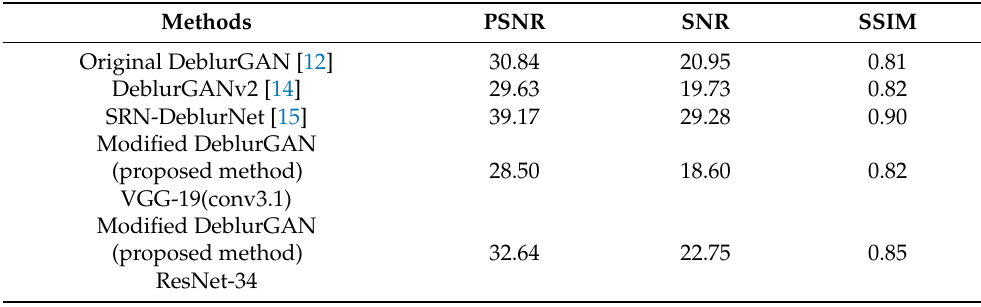
Table 10. Comparisons of blur restoration by using the state-of-the-art methods and proposed modified DeblurGAN with SDU-DB.